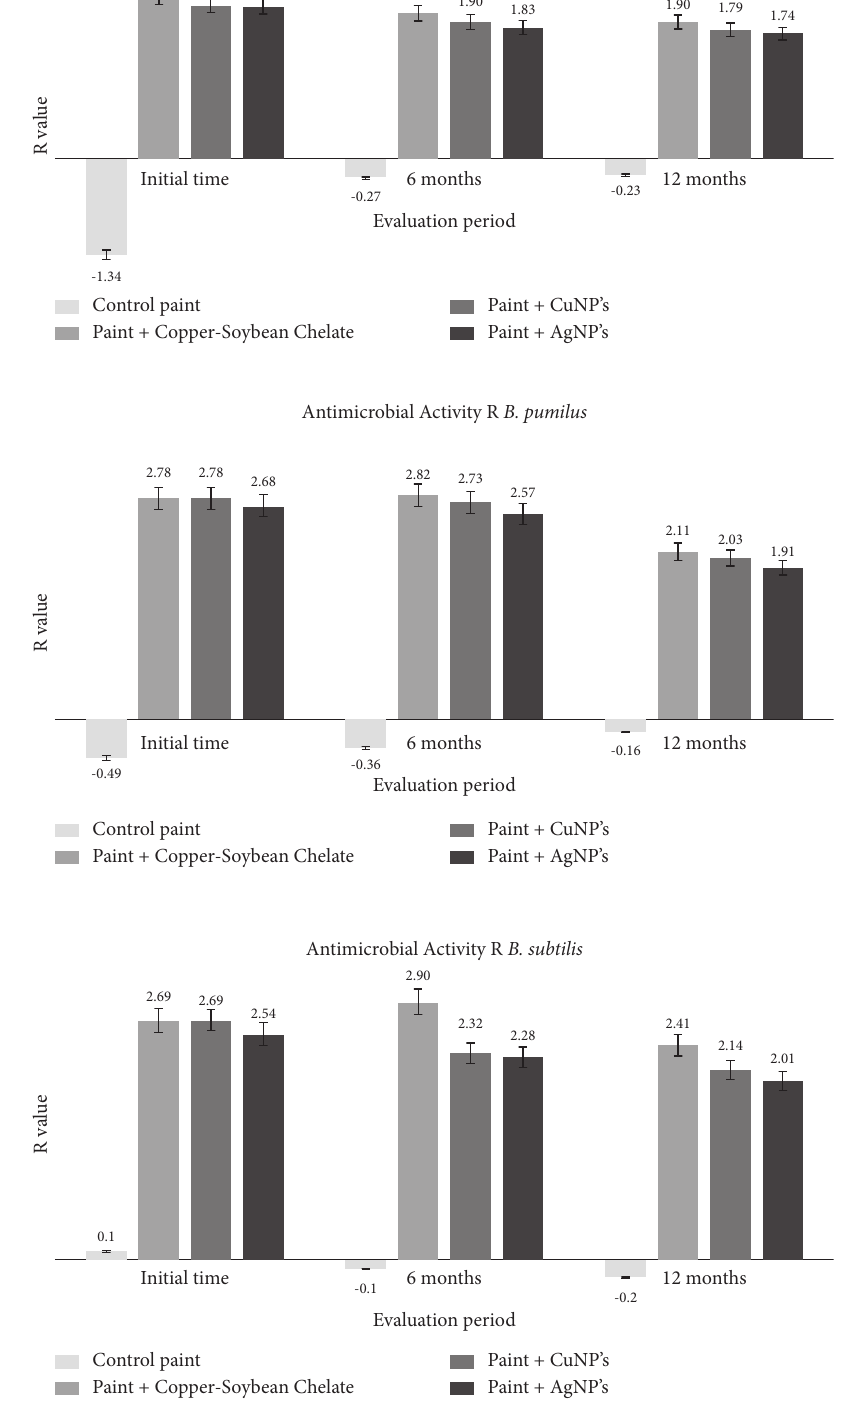
Figure 7: Antibacterial activity R of paint